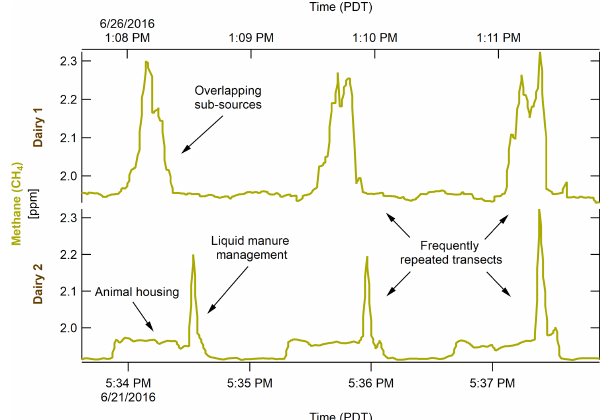
Figure 4. Selected sampling periods (approximately 5min) at each dairy farm showing characteristics of emitted methane plumes as observed by the aircraft downwind to the south. Each time trace depicts the high rate of repetition in the flown transects around each